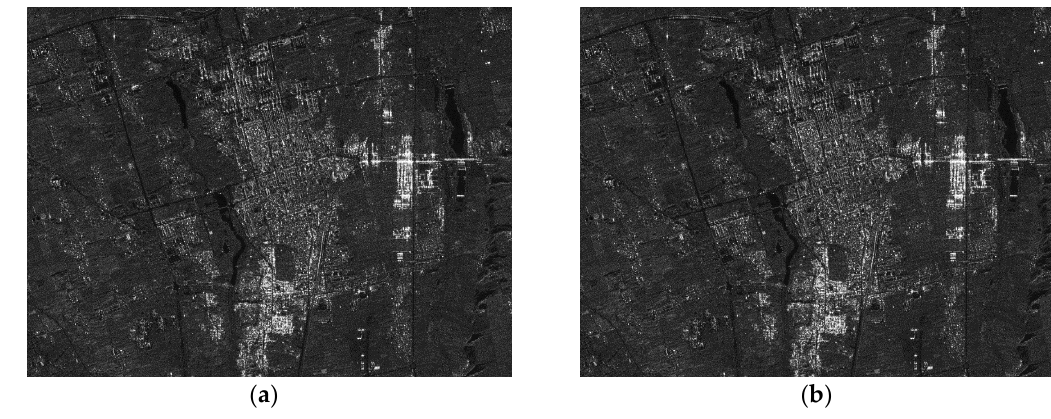
Figure 12. Results of area A (from top to bottom is range, and from left to right is azimuth): ( a ) standard full-aperture CSA; ( b ) proposed algorithm.